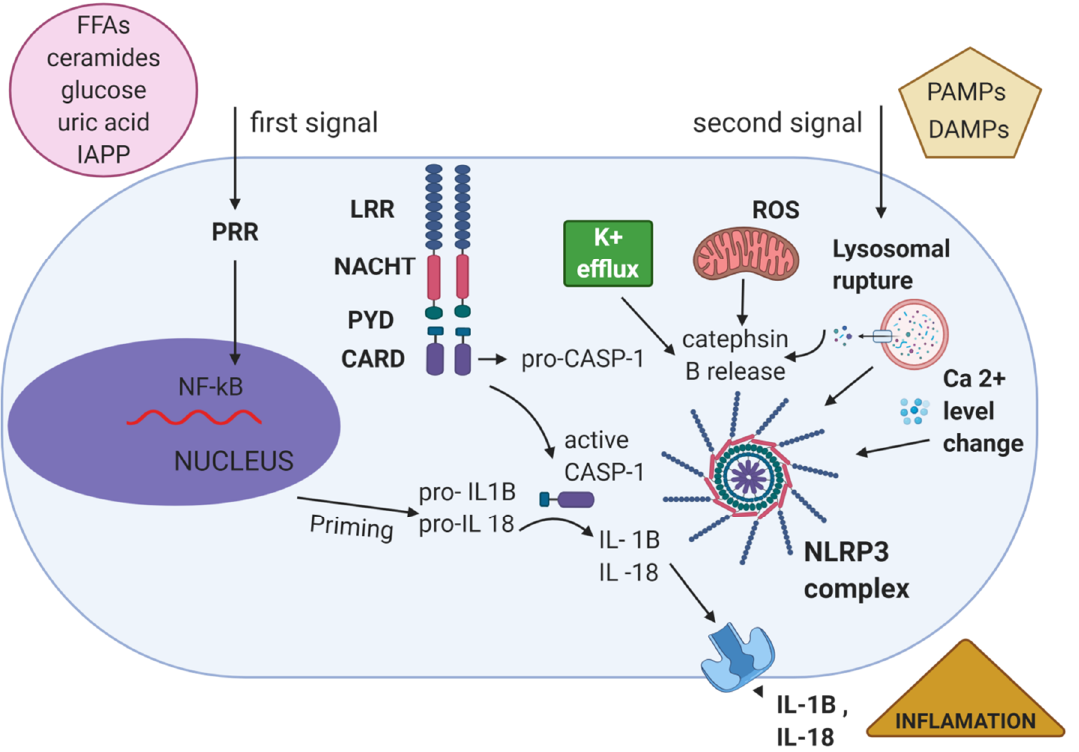
Figure 2. NLRP3 activation